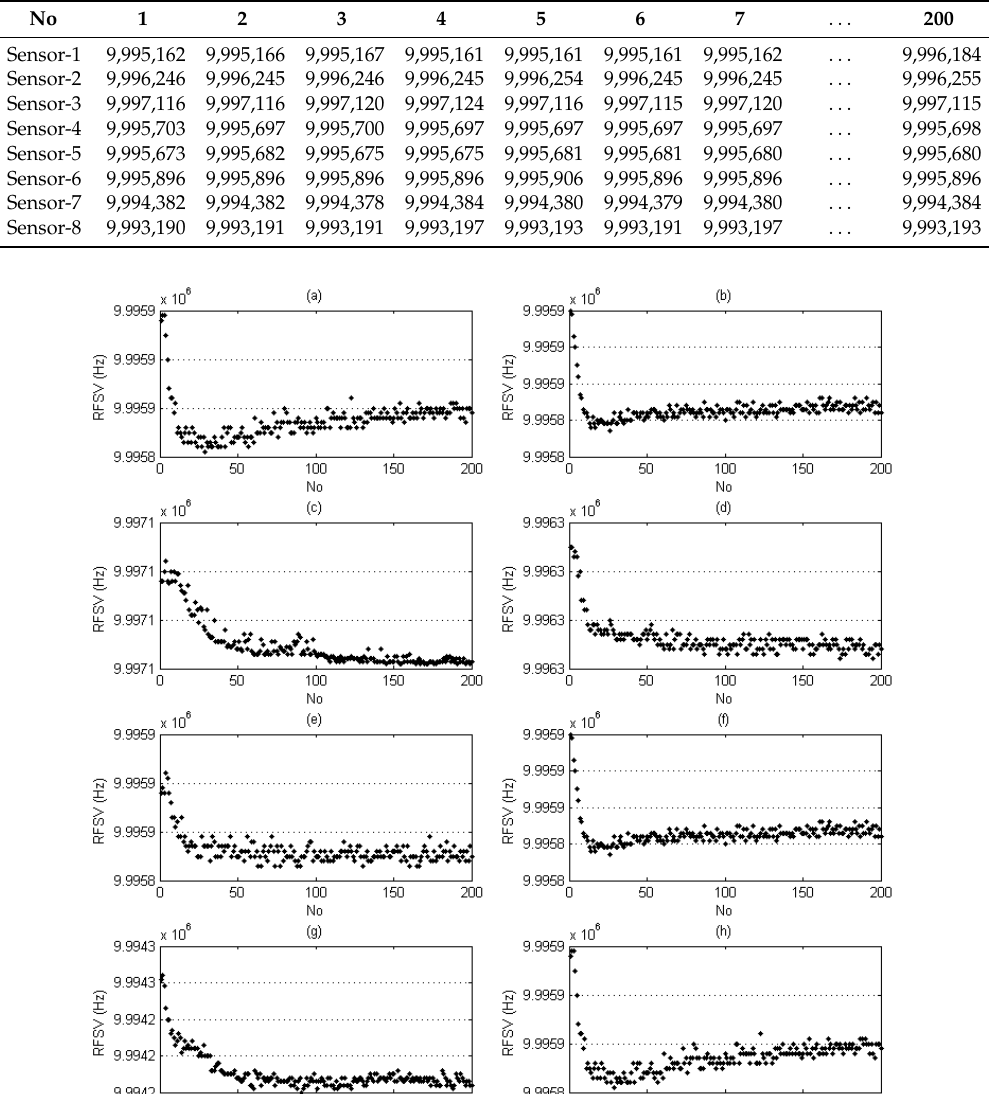
Figure 8. Group of raw data of the Moutai sample’s characteristic information from Sensor-1 to Sensor-8: ( a ) Sensor-1; ( b ) Sensor-2; ( c ) Sensor-3; ( d ) Sensor-4; ( e ) Sensor-5; ( f ) Sensor-6; ( g ) Sensor-7; ( h ) Sensor-8.